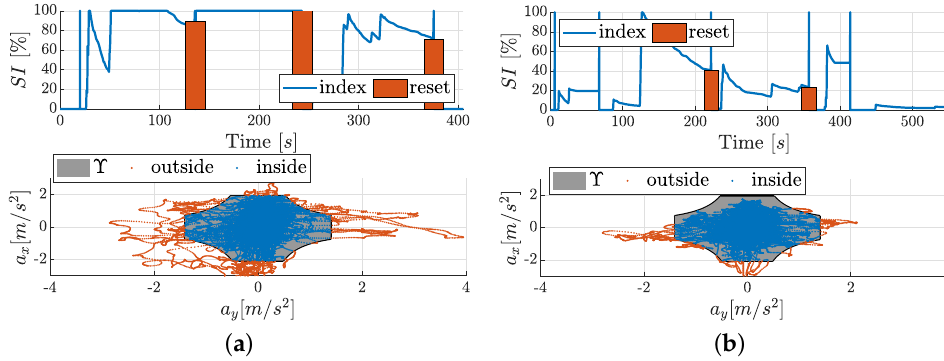
Figure 18. Safety Index and g-g plots, for two urban driving tests, an aggressive one (upper plot), and a not-aggressive one (lower plot). ( a ) Aggressive driving. ( b ) Calm driving